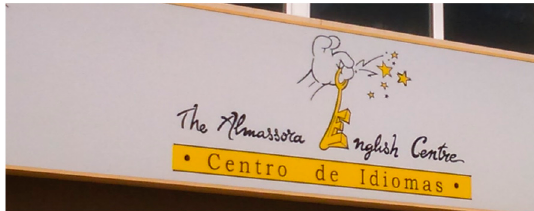
Figure 32. Almazora: English-Valencian sign on a language academy .